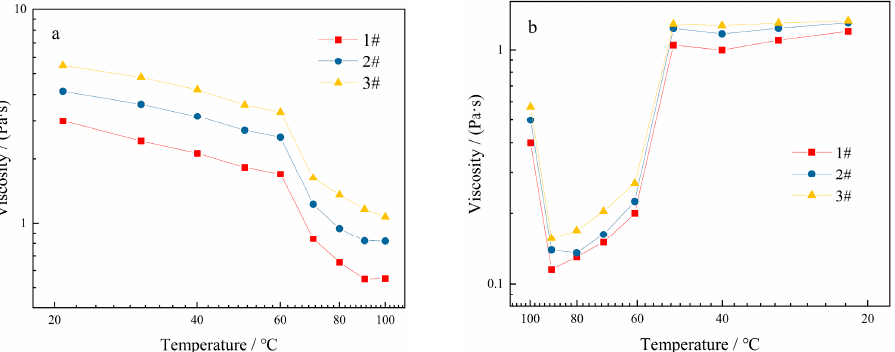
Figure 12. Effect of temperature on viscosity of thickening components with different formulations: ( a ) temperature rise; ( b ) temperature drop.